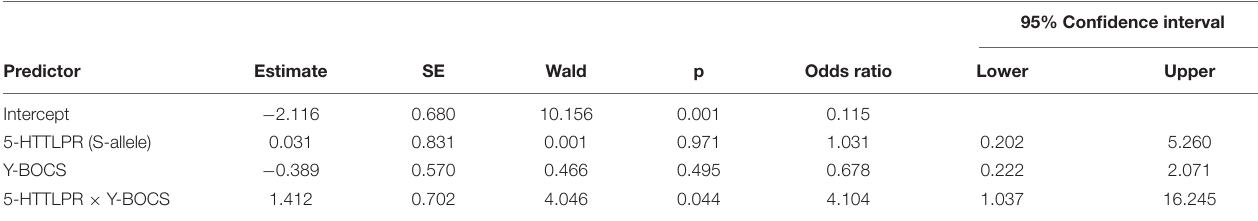
TABLE 3 | Logistic regression analysis predicting multiple suicide attempts from 5-HTTLPR, chronic OCD symptoms, and the interaction between 5-HTTLPR and chronic OCD